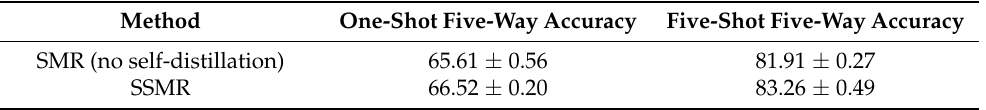
Table 9. A study of the accuracy (%) of the five-way task when performed with five shots and one shot between training with self-distillation or withouut. All average results are shown with 95% confidence